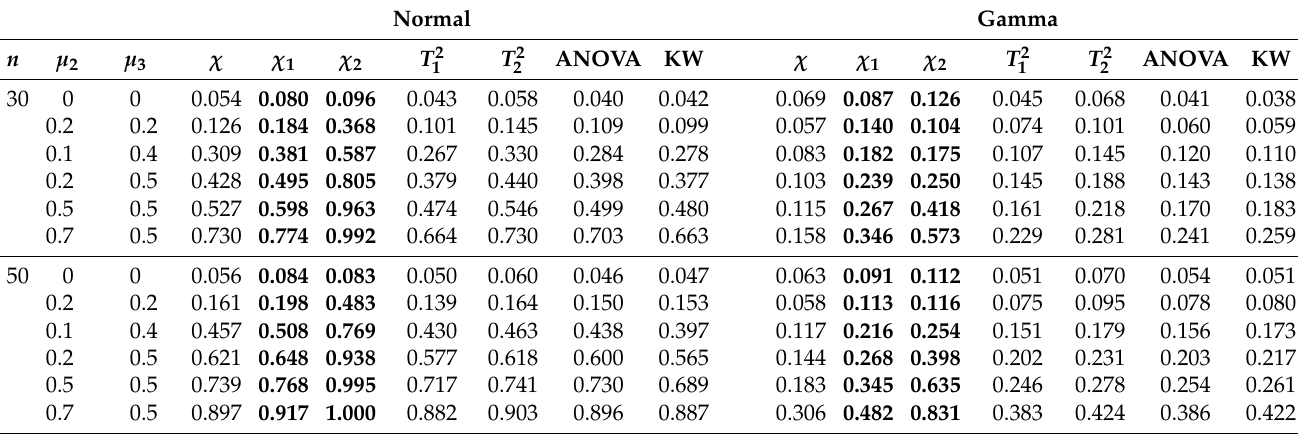
Table 2. Power comparison with equal sample sizes.